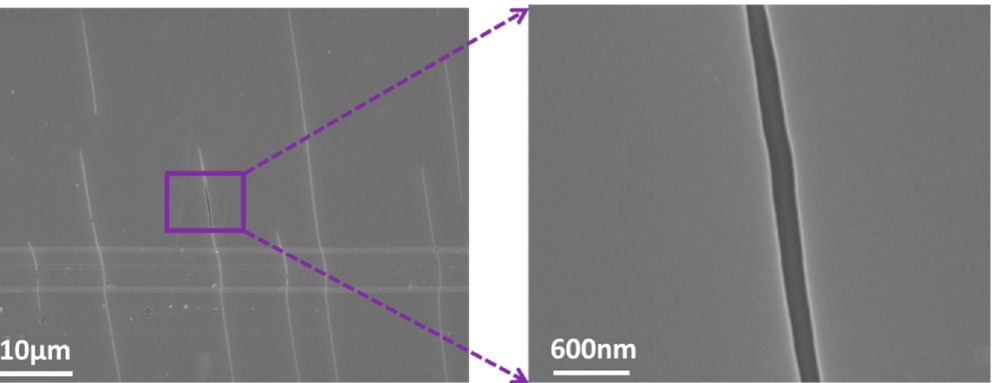
Figure 7. Surface topography of the siloxane coating with the thickness of 615 nm after the damp-heat test and adhesion test.